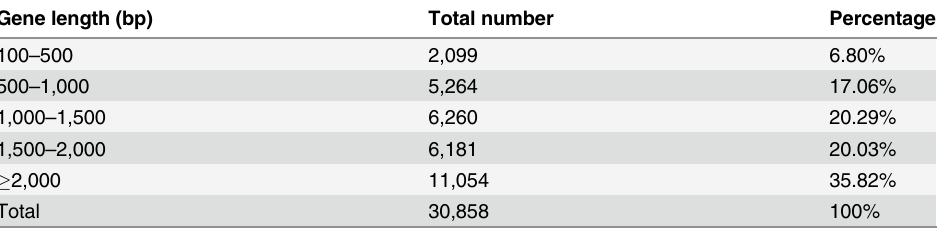
Table 2. Sequence length distribution of the all 30,858 detected genes in the leaf and four develop- mental stages of